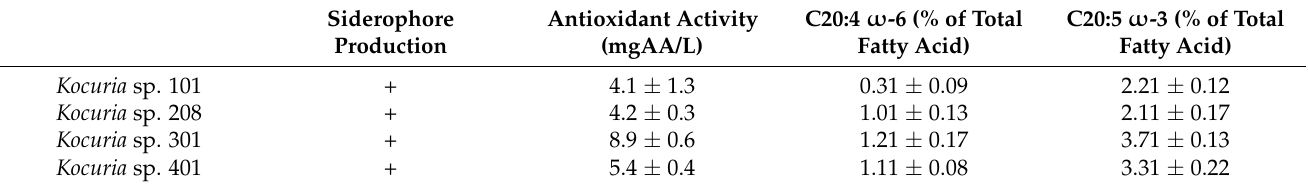
Table 2. Polyunsaturated fatty acid content at 20 ◦ C, siderophore and antioxidant production of four Kocuria sp. isolates from Jachymov radon